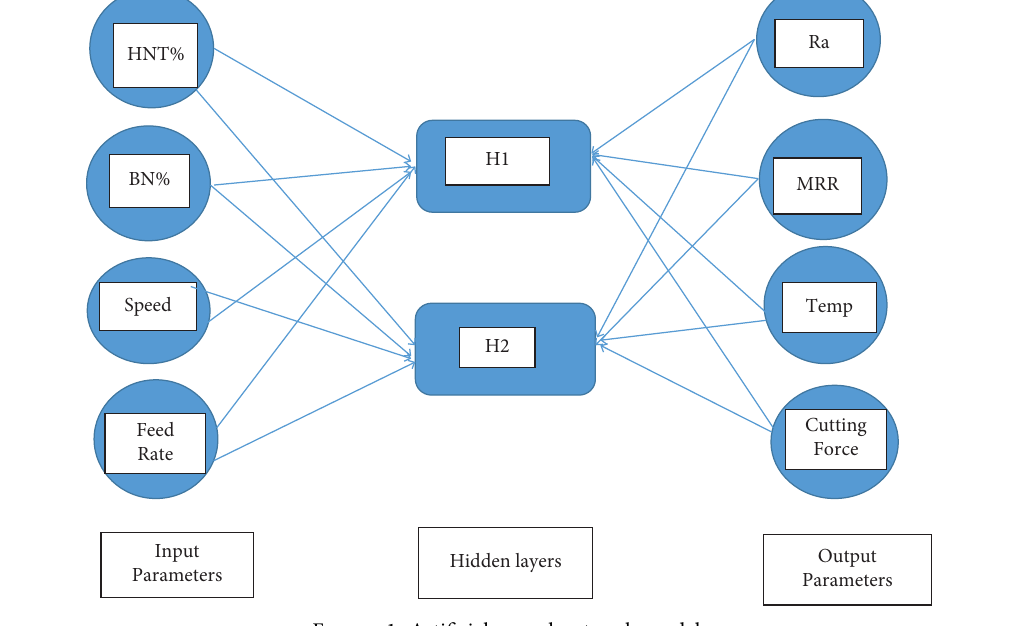
Figure 1: Artifcial neural network Table 4: L 27 orthogonal array and results.